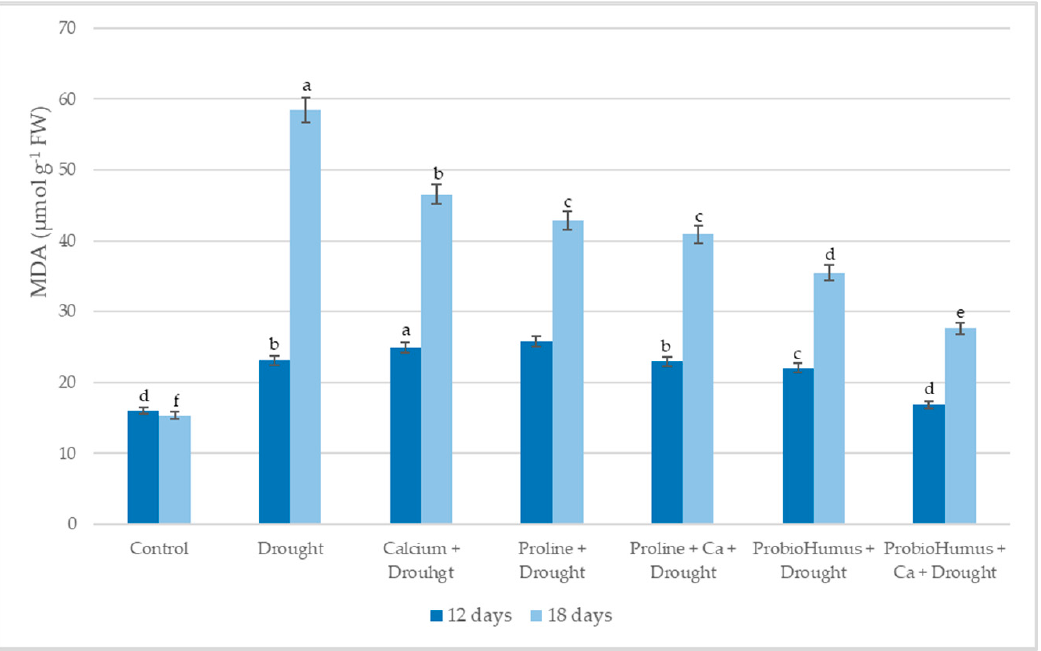
Figure 5. The effect of stress-protecting compounds application and prolonged drought stress (12 and 18 days) on winter wheat MDA content. Error bars represent the standard deviation of the mean. Control, Ca, proline, proline + Ca, ProbioHumus, and ProbioHumus + Ca indicates the type of application. Different lowercase letters in the same day of drought indicate statistically significant differences ( p <